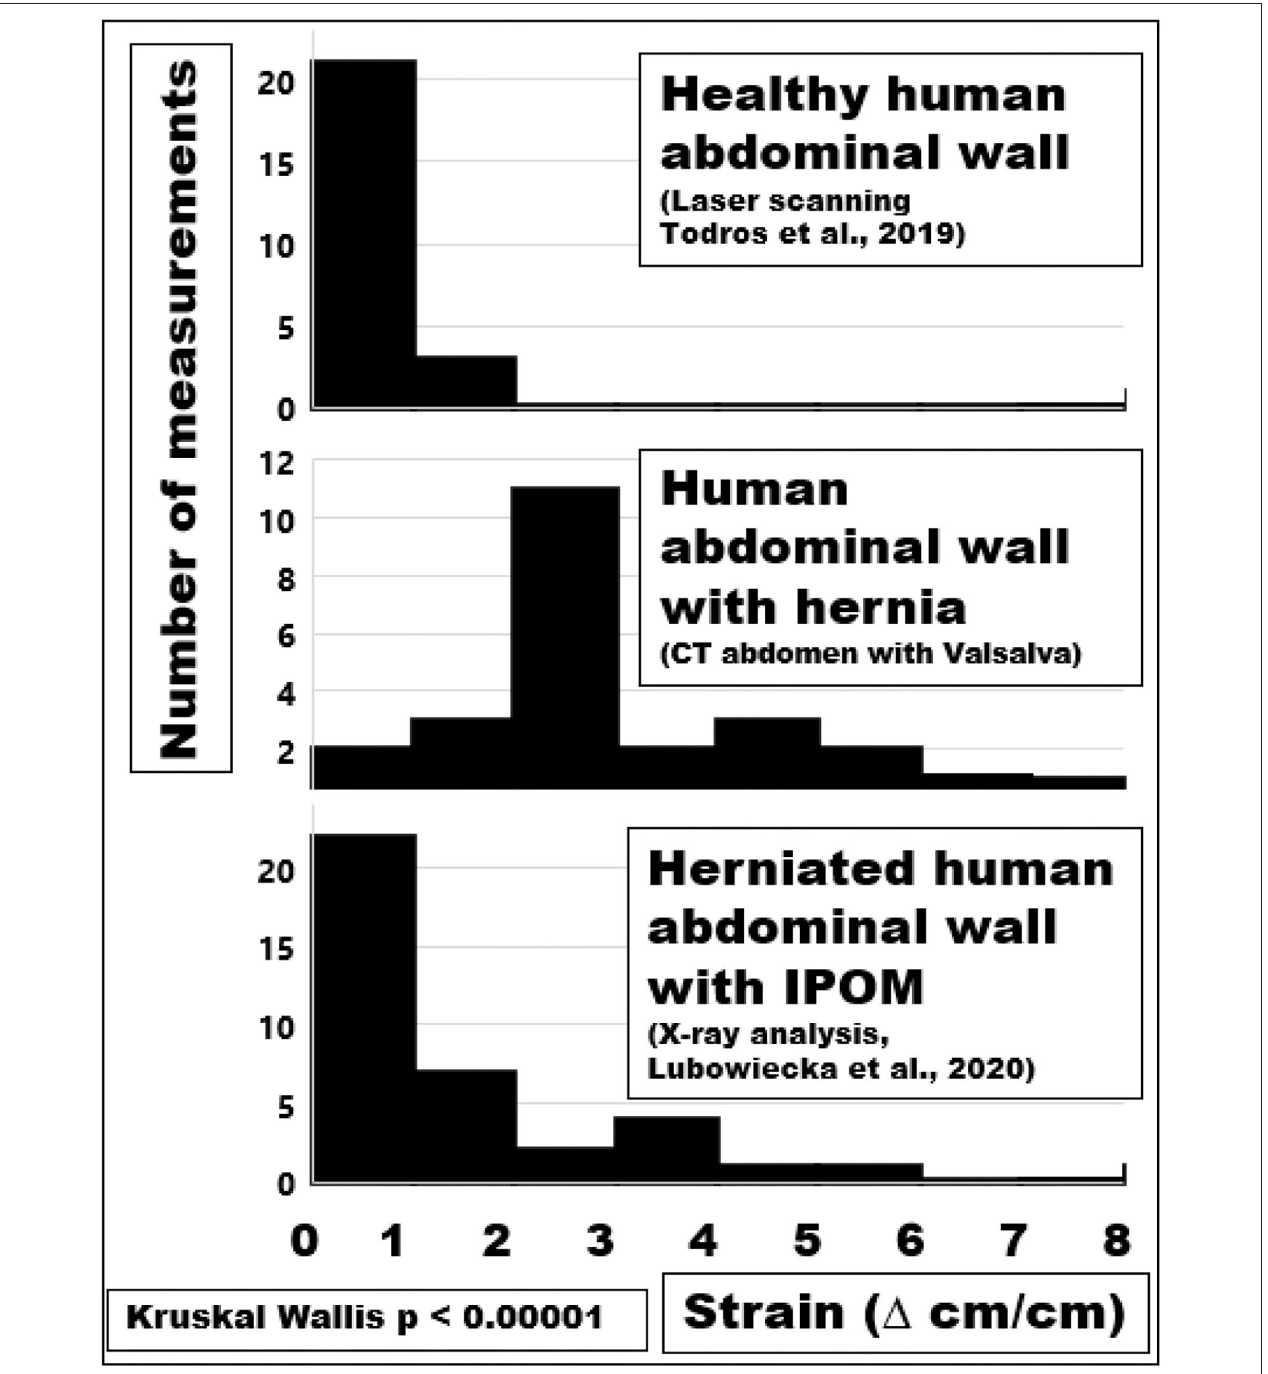
FIGURE 9 | Histograms of the maximum strain distributions of a healthy or herniated abdominal wall compared with values after an IPOM repair (from top to bottom)